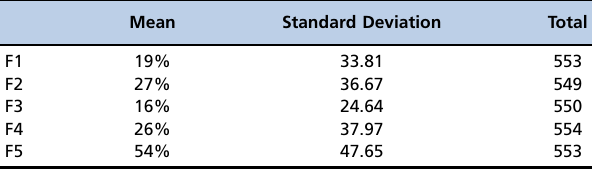
Table 4 - Final score means stratified by the factors.